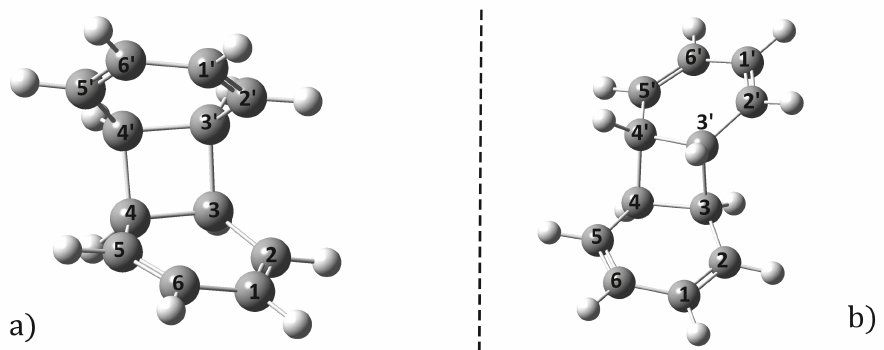
Figure 5. The cyclobutane benzene dimer geometry with syn - ( a ) and anti - ( b ) conformations com- puted at the DFT- ω B97X-D3/ma-def2-TZVPP level of